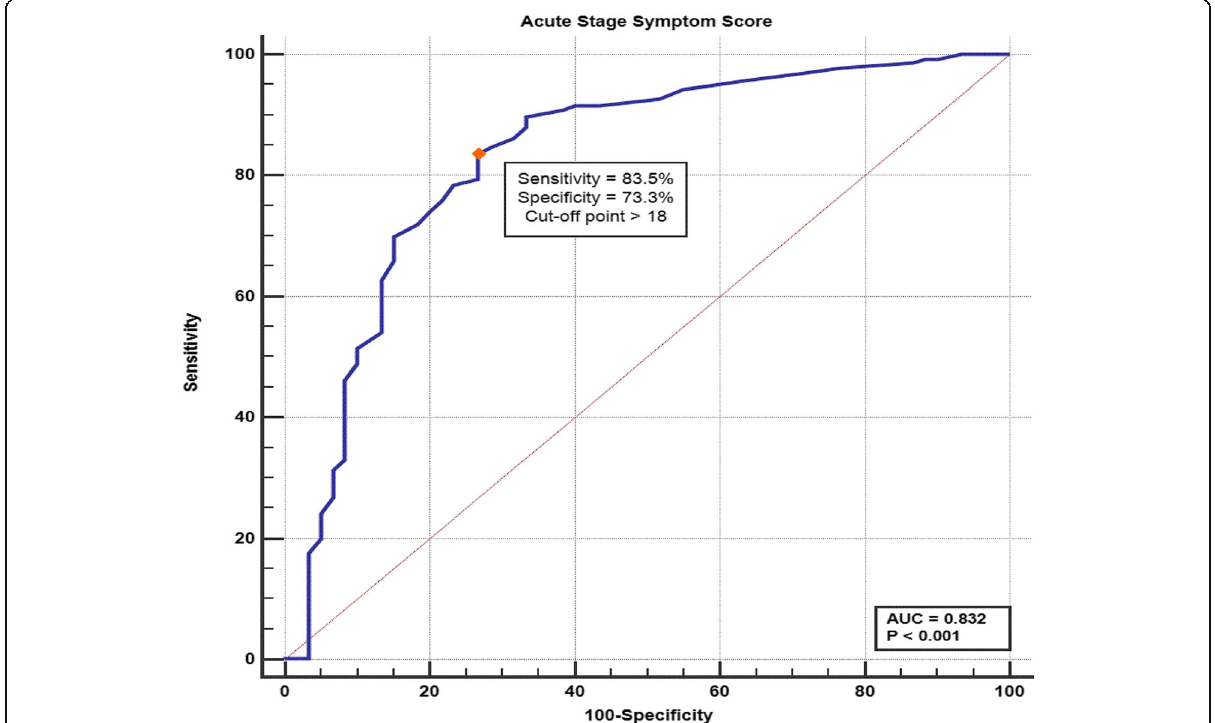
Fig. 4 ROC curve for the acute stage symptom score as a predictor of persistent post-COVID symptoms